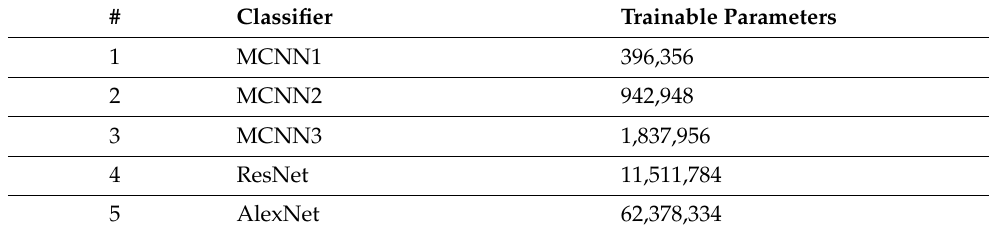
Table 8. Comparative analysis of trainable parameters for proposed multi-scale and existing DL architectures.